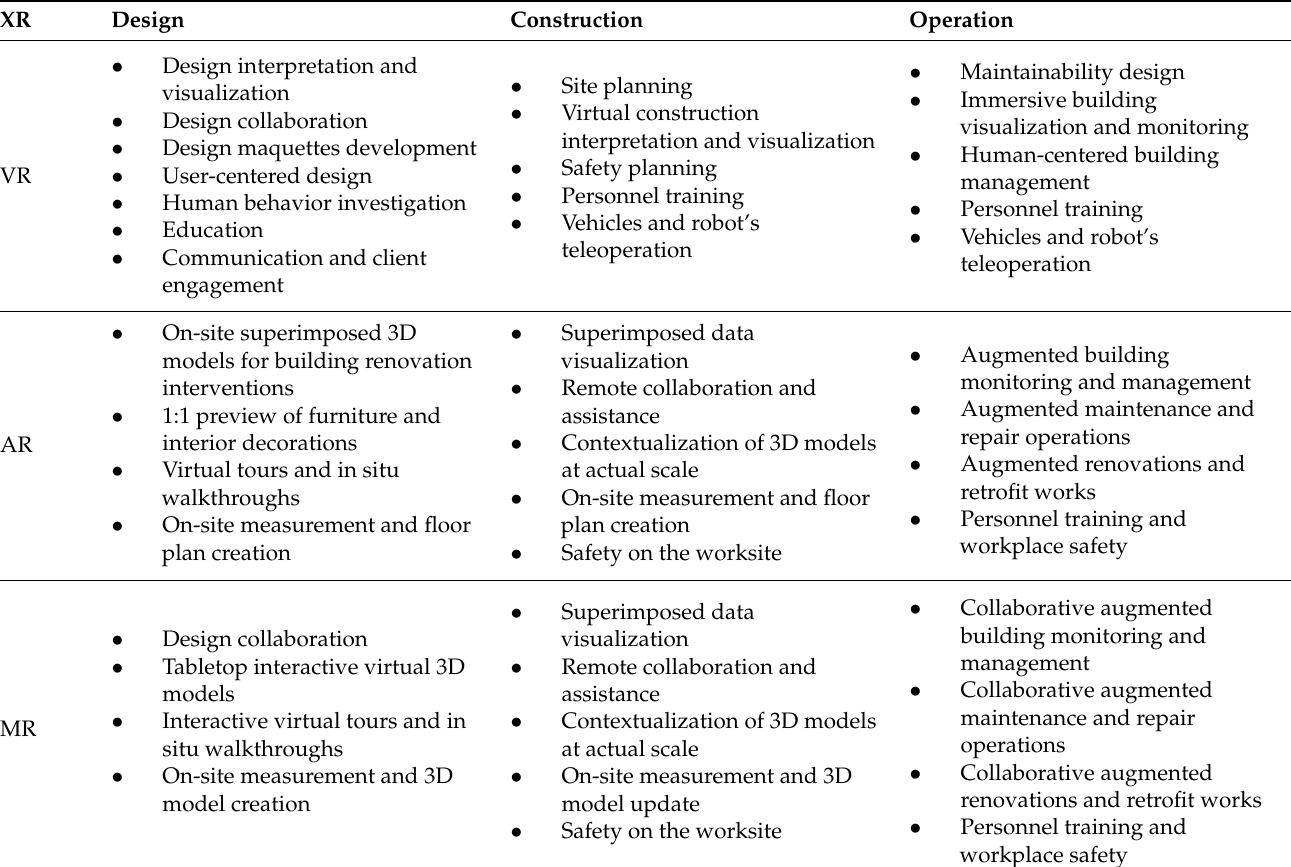
Table 5. Main XR applications in AECO